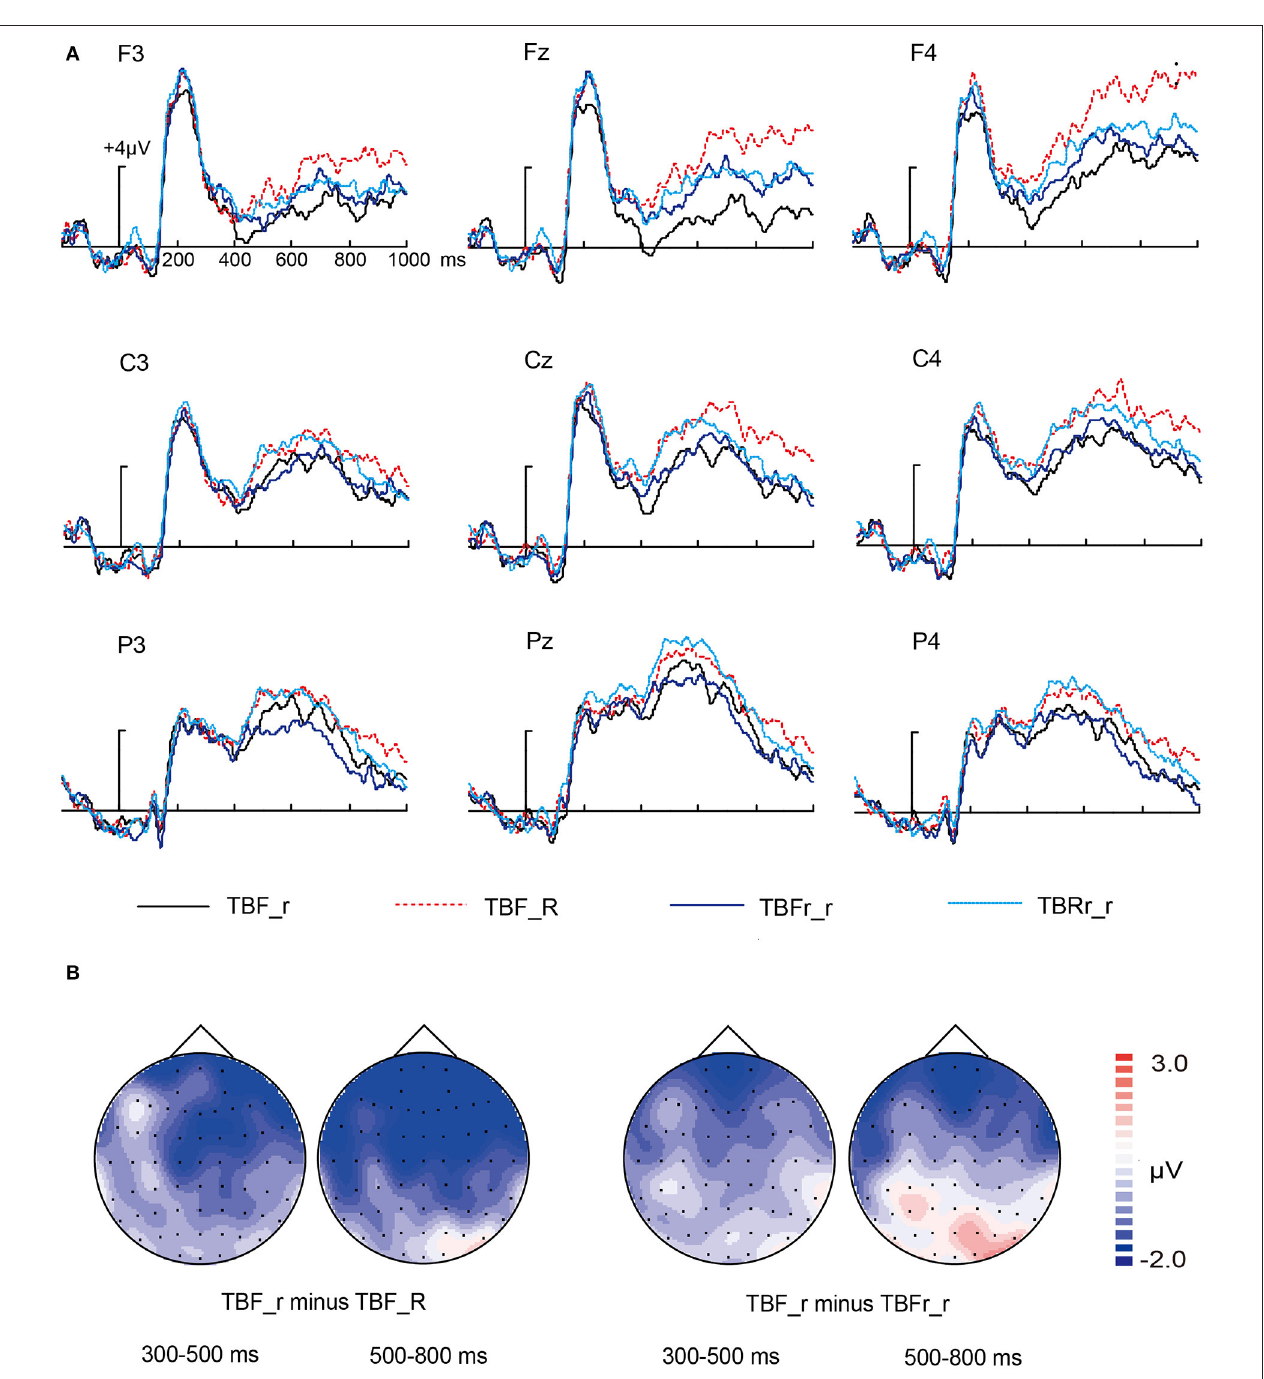
FIGURE 5 | ERP for TBF_r, TBF_R, TBFr_r, and TBRr_r condition. (A) Waveforms are shown from F3, Fz, F4, C3, Cz, C4, P3, Pz, and P4 electrodes. (B) The left two topographical plot depict ERP differences between TBF_r condition and TBF_R condition at 500–800ms interval; the right two topographical plots depict ERP differences between TBF_R condition and TBFr_r condition at 300–500ms interval and 500–800ms interval.